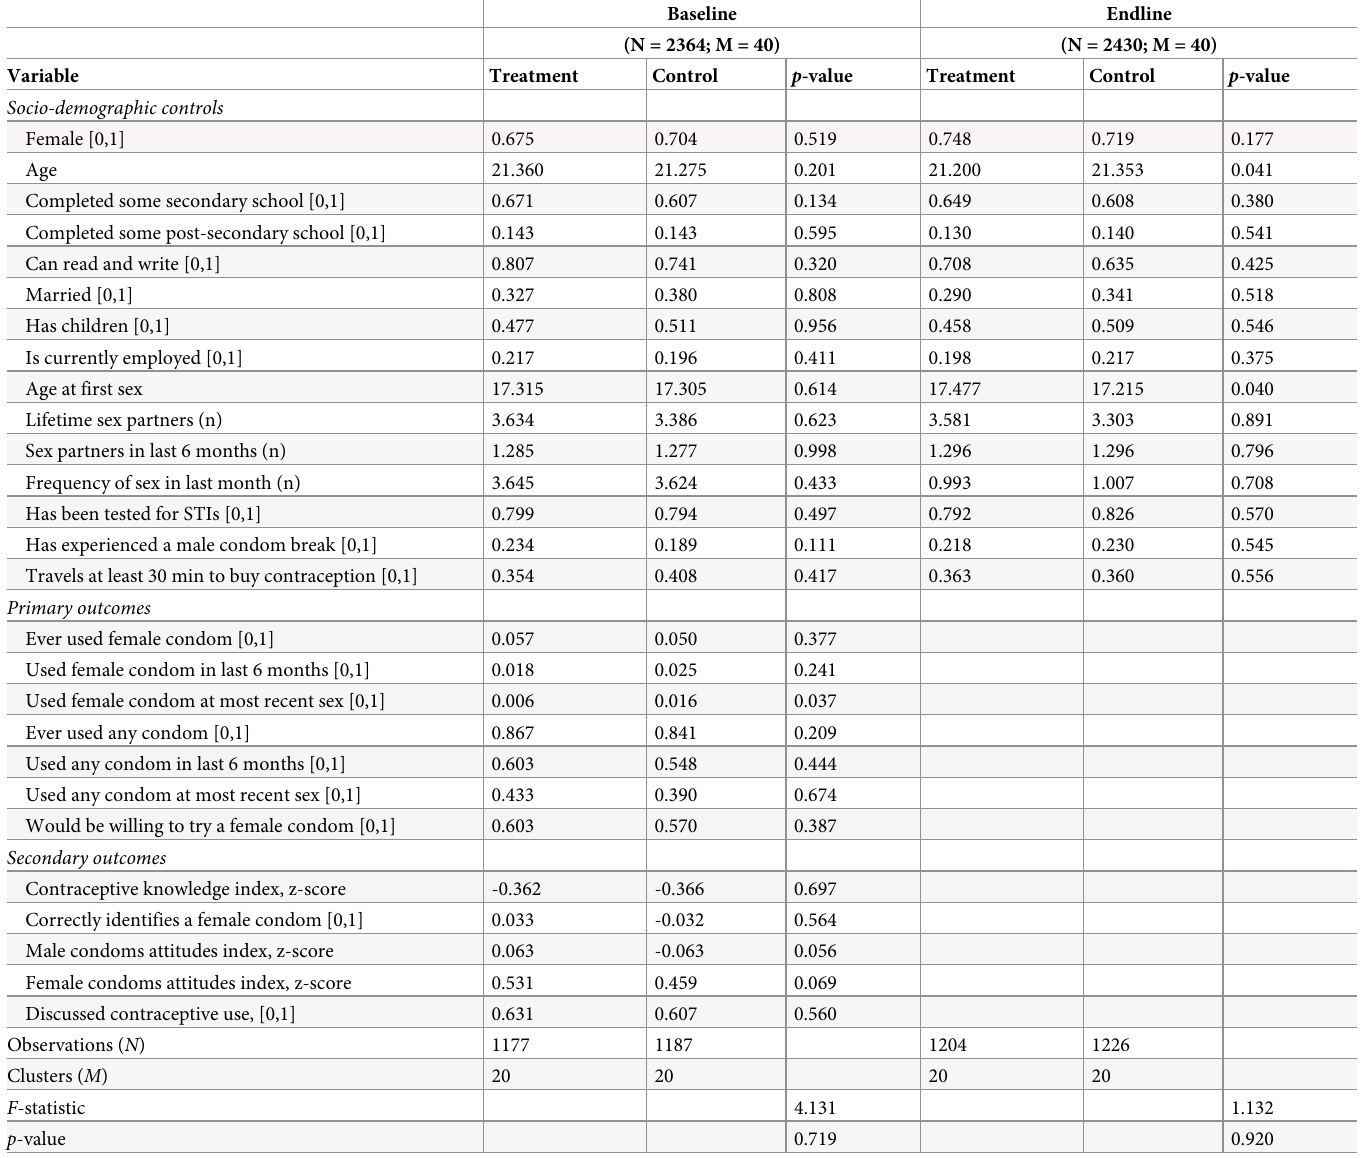
Table 2. Characteristics of treatment and control wards, Lusaka, Zambia 2015 (Balance